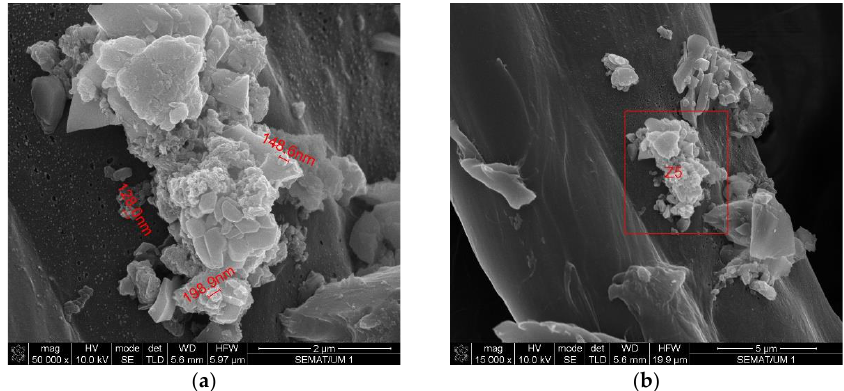
Figure 7. SEM analysis results: airborne sample collected on quartz filter. ( a ) Size and shape of particles in the sample; ( b ) image of the particle analyzed by EDS (results in Figure 8).